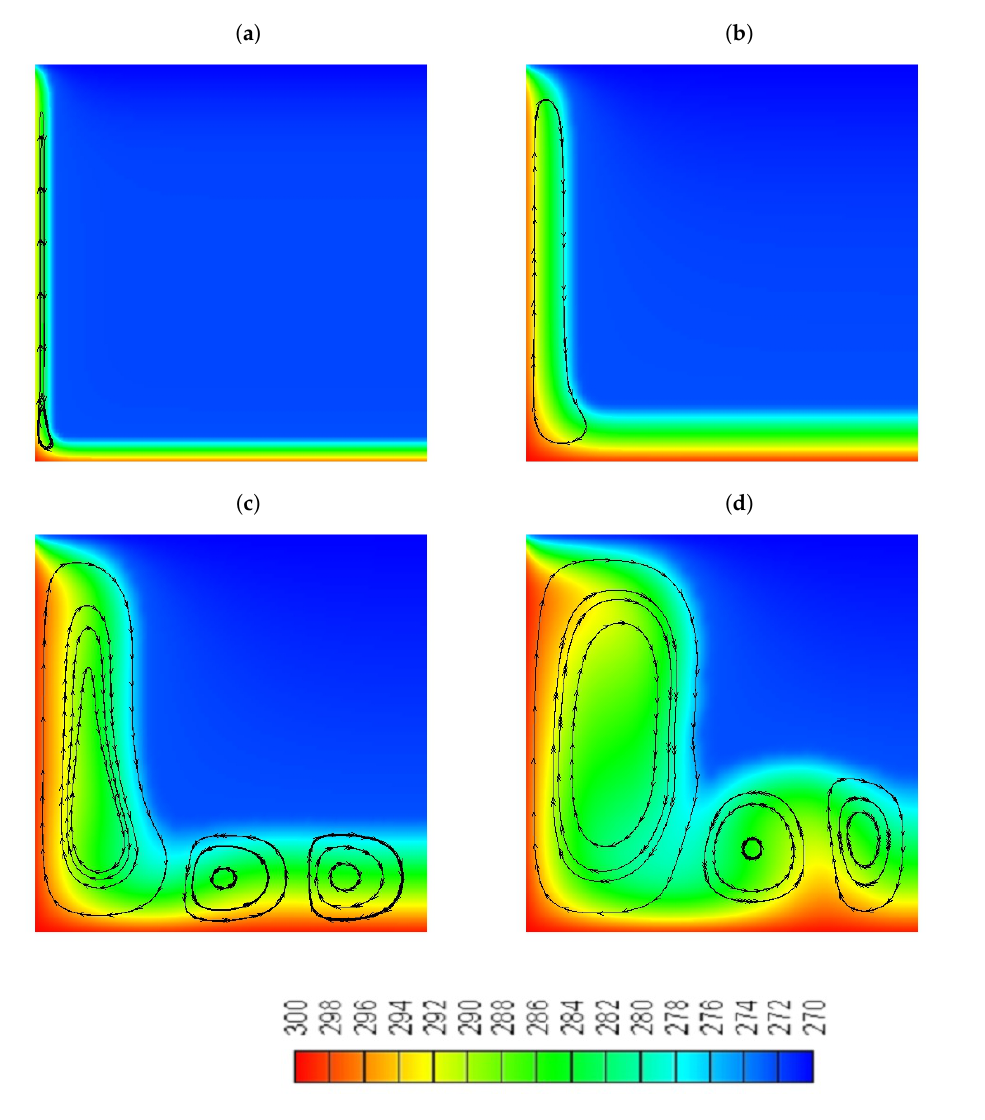
Figure 5. The evolution of temperature profiles for the case of φ w = 10%. ( a ) t = 2 s, ( b ) t = 6 s, ( c ) t = 25 s, ( d ) t = 50